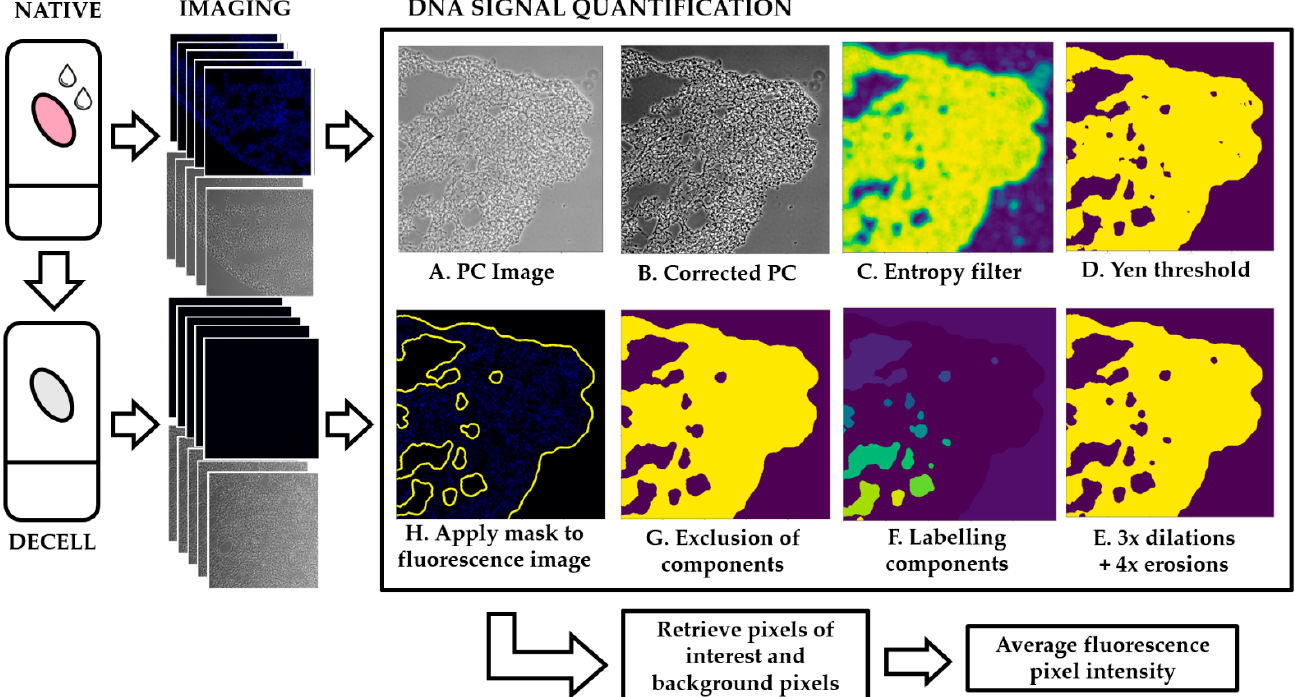
Figure 1. Schematic layout of the image processing pipeline. Native and decellularized samples are imaged and sets of image pairs (PC + UV) are taken. UV signal quantification: ( A ) the PC image is selected and ( B ) normalized for increased contrast. ( C,D ) An entropy filter is applied where high entropy regions correspond to high intensity regions and low entropy regions correspond to low intensity regions. ( E ) Three dilations followed by three erosions are applied to create smaller pixels aggregates and ( F ) these components are labelled. ( G ) Components are excluded/included in the mask depending on number of pixels. ( H ) The mask is applied to the UV image to identify pixels of interest corresponding to tissue vs. the background.